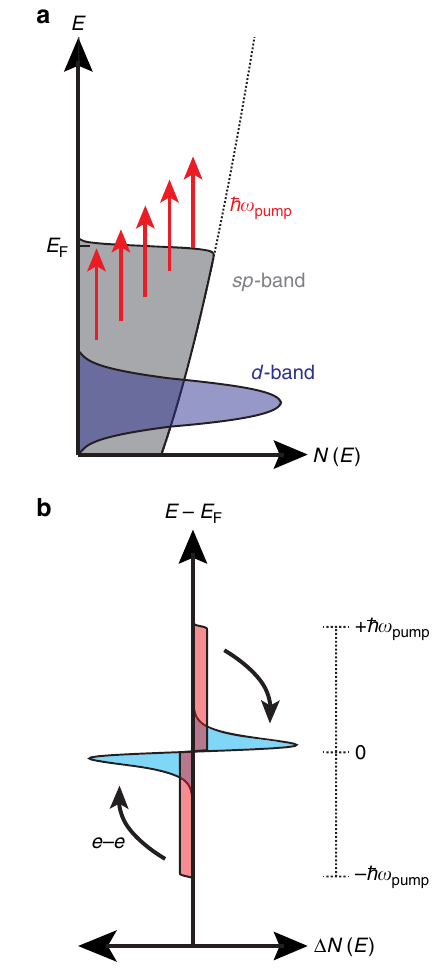
Fig. 1 Hot electron distributions from intraband excitation. a Representative electronic density of states ( N ) diagram for noble metals under intraband pumping conditions. Free electrons in the sp -band capture the energy of the pump photons ( ħ ω pump ) during plasmon dephasing and promote a distribution of electron – hole pairs. b Nonthermal (red) carriers initially form a symmetric step-wise distribution relative to the Fermi energy ( E F ) upon excitation. After electron – electron (e – e) scattering, a thermalized electron population (cyan) with a Fermi – Dirac distribution is formed from the nonthermal electrons with an electronic temperature above that of the